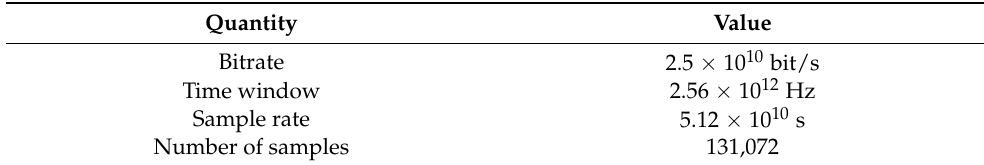
Table 2. Simulation settings used to calculate the CS-AMZM.